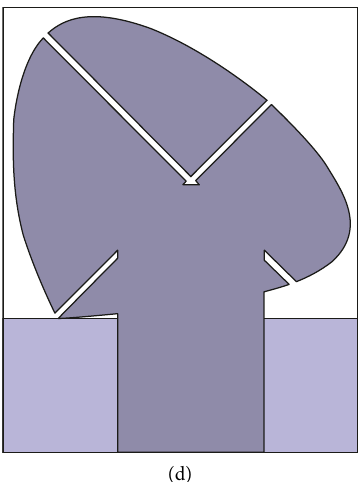
Figure 2: Evolution of the proposed antenna. (a) Config A, (b) config B, (c) config C, (d) config D.